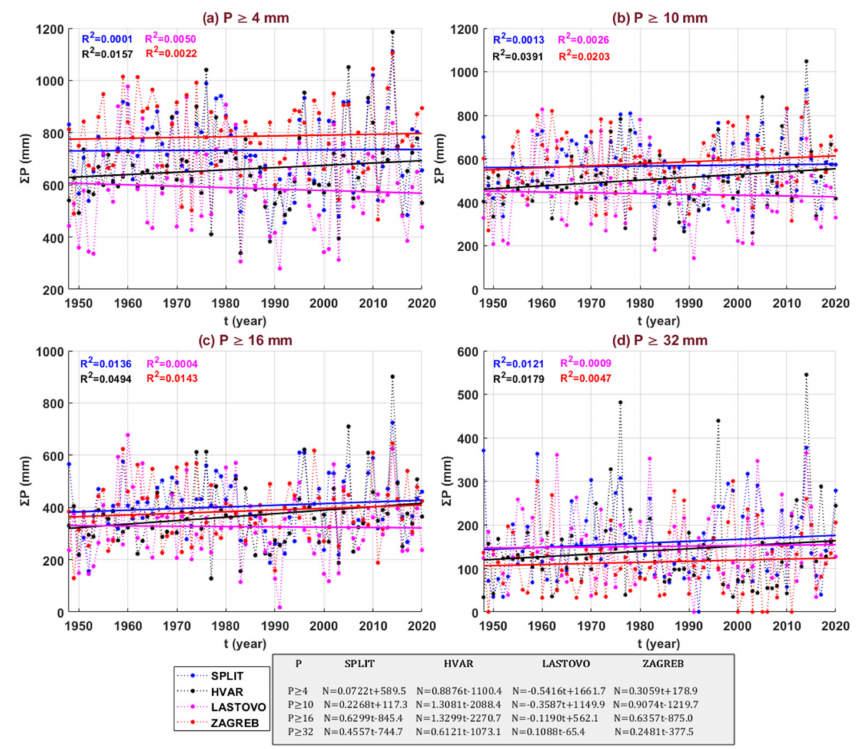
Figure 6. Time series of the sum of precipitations in a year, Σ P, with precipitation, P ≥ 4.0 mm ( a ),